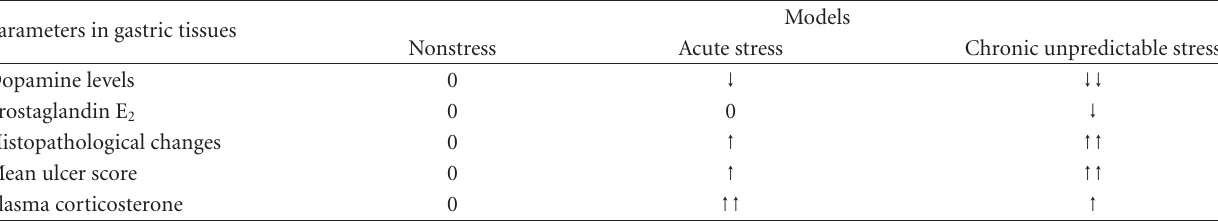
Table 1: Acute and chronic unpredictable stress-induced alterations in dopamine, prostaglandin E 2 levels, histopathological changes, and mean ulcer score in gastric